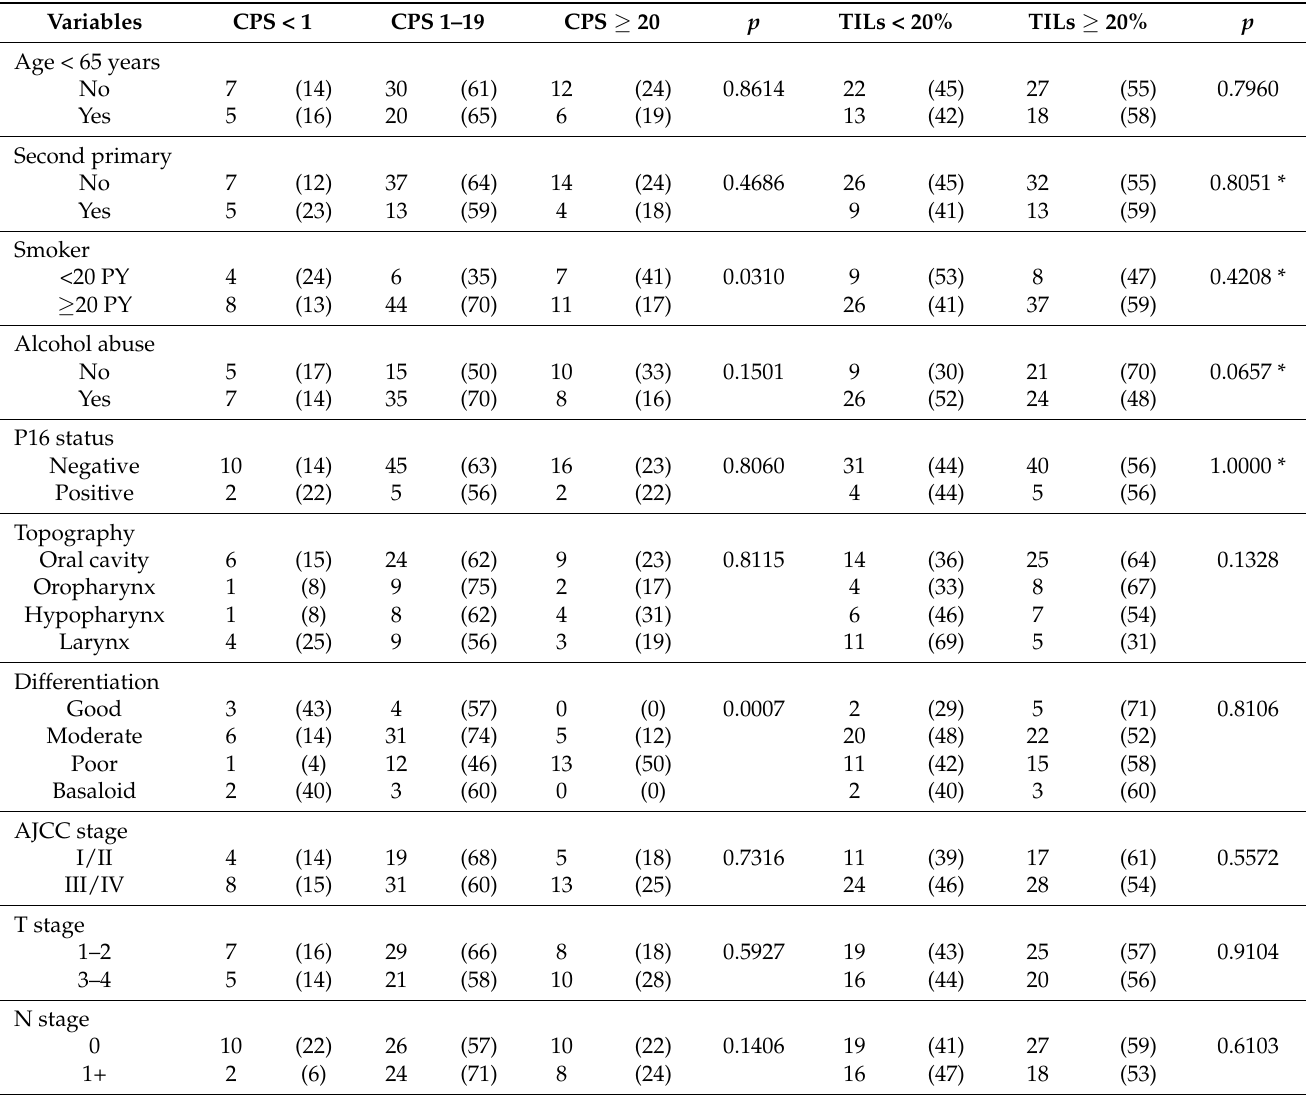
Table 4. Clinicopathological variables vs. CPS and TILs